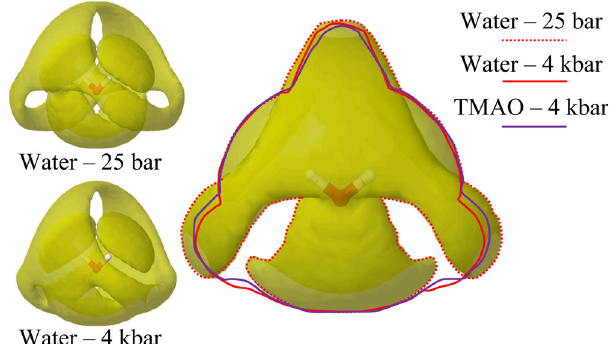
Fig. 3 Water – water SDFs. The water – water spatial density functions (SDFs) for pure water at 25 bar and 4 kbar as viewed from 35° normal to the plane of the central water molecule. The water – water SDF for pure water at 25 bar as viewed normal to the plane of the central water molecule. This SDF is outlined (red dashed) and the outline of pure water at 4 kbar (solid red) and the outline of aqueous TMAO at 2.0 mol kg − 1 H 2 O at 4 kbar (solid purple) are superimposed onto the image. These isosurfaces represent the 30% most probable areas of fi nding a neighbouring water molecule relative to a central water